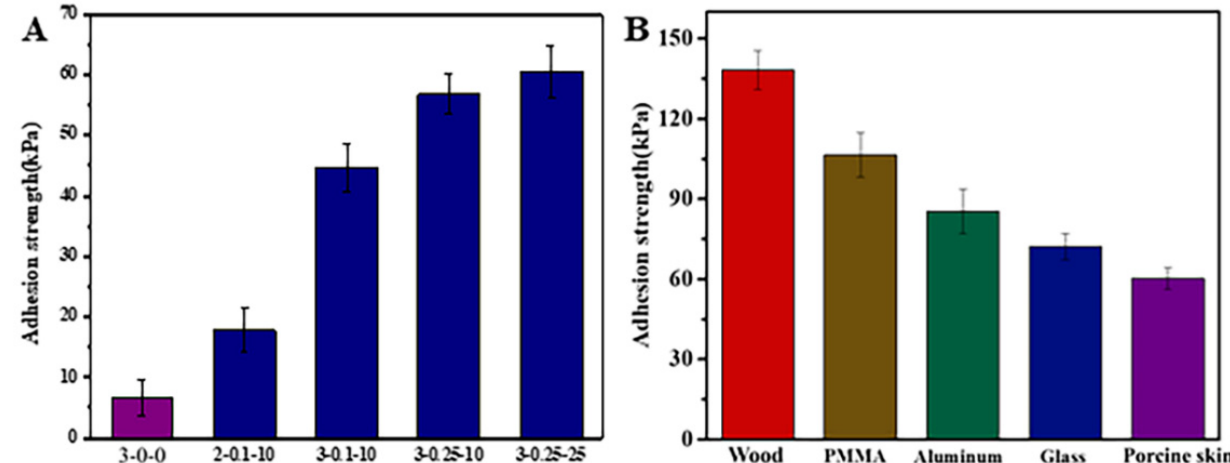
Figure 7. Adhesion strength of CS-TBA-Fe hydrogels with different structures on porcine skin ( A ) and comparison of the adhesion strengths in bonding various substrates ( B ).